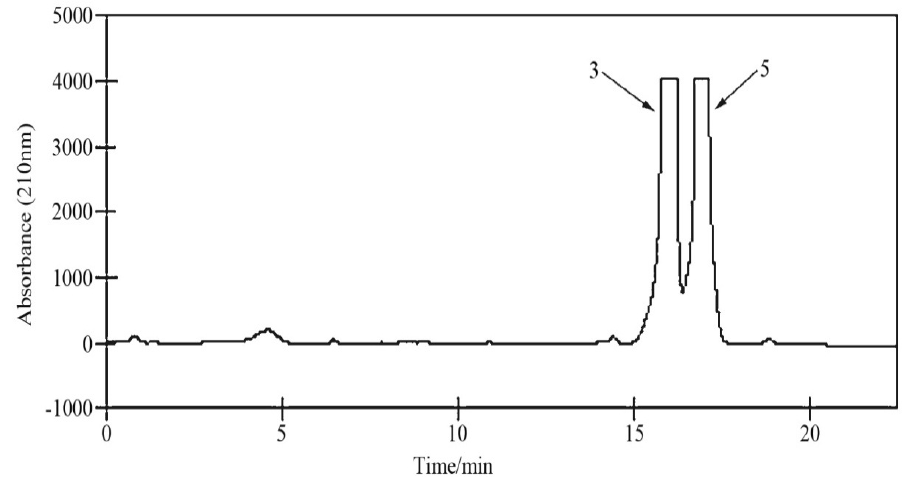
Figure 4. Prep-HPLC chromatogram of compounds 3 and 5 . Mobile phase: methanol-water (98:2, v / v ); wavelength: 210 nm; flow rate: 3 mL/min.